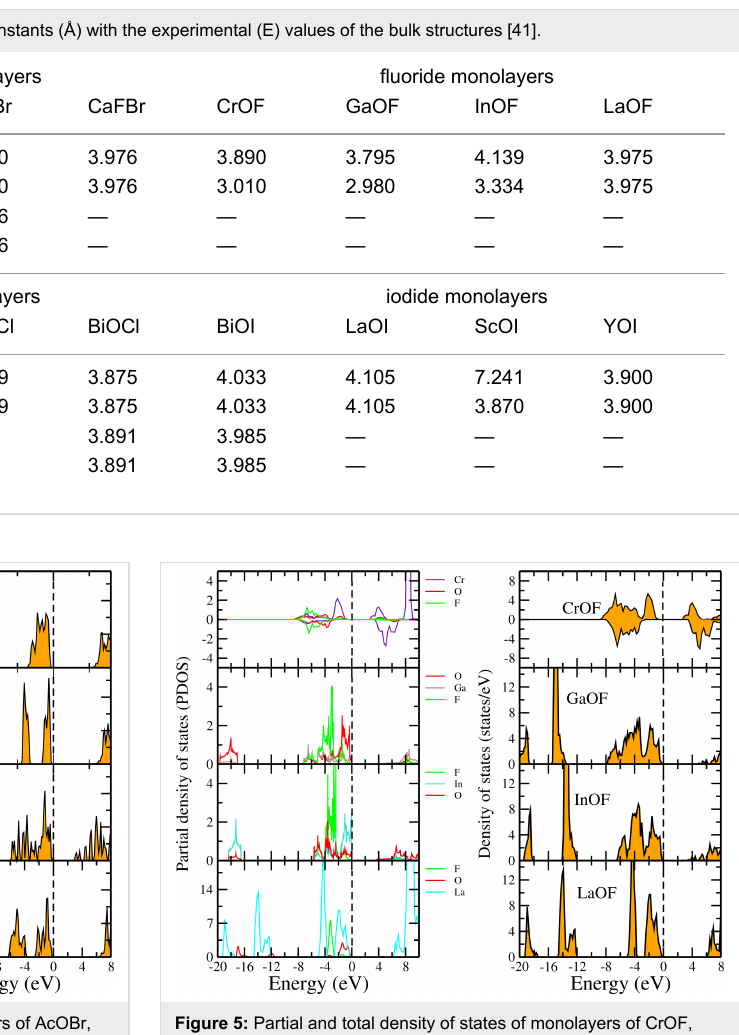
Figure 5: Partial and total density of states of monolayers of CrOF, GaOF, InOF, and LaOF. The Fermi level is set to 0 eV.